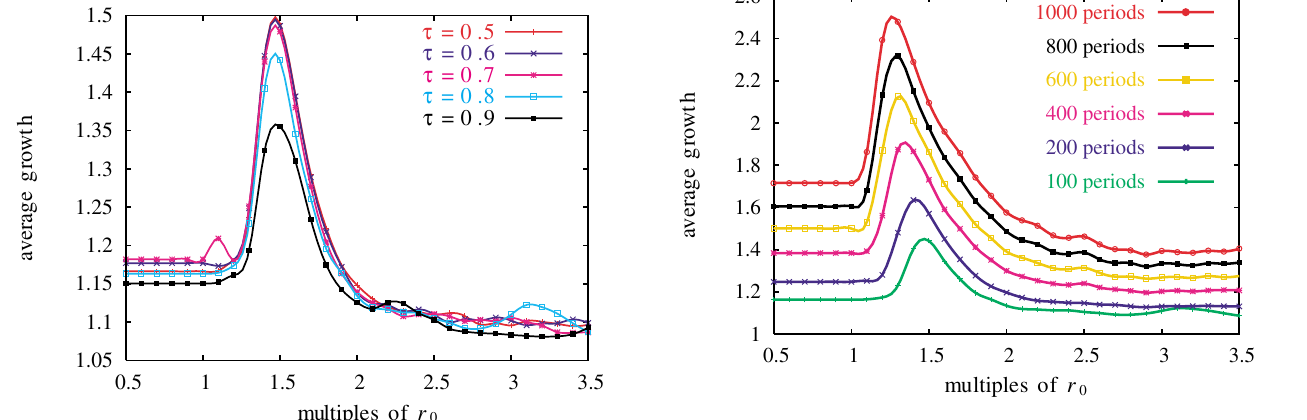
FIG. 8. (Color) Maximum amplitude growth for single par- ticles as a function of their initial radius and the length of the transport channel (in zero-current betatron periods). Each dot represents the averaged results of 1000 runs with different error sets for a tune depression of (cid:18) (cid:3) 0 : 8 and an rms error amplitude of 1%.